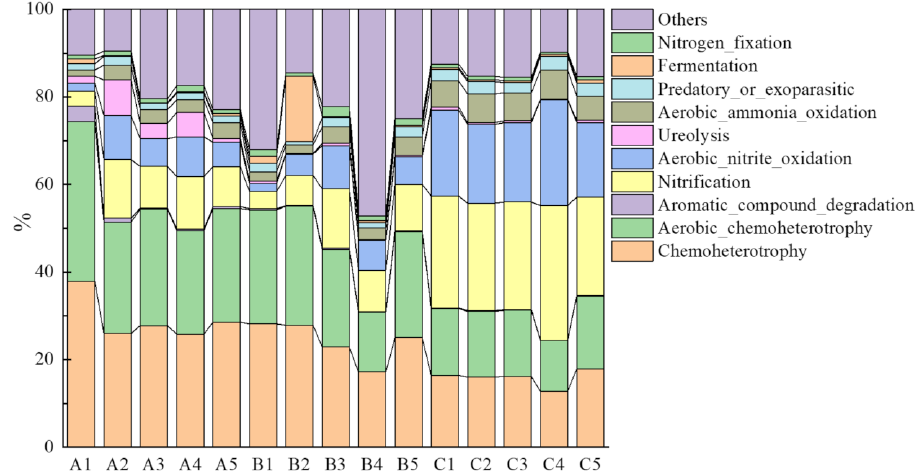
Figure 4. Abundance of functional groups of bacterial communities among soil samples.